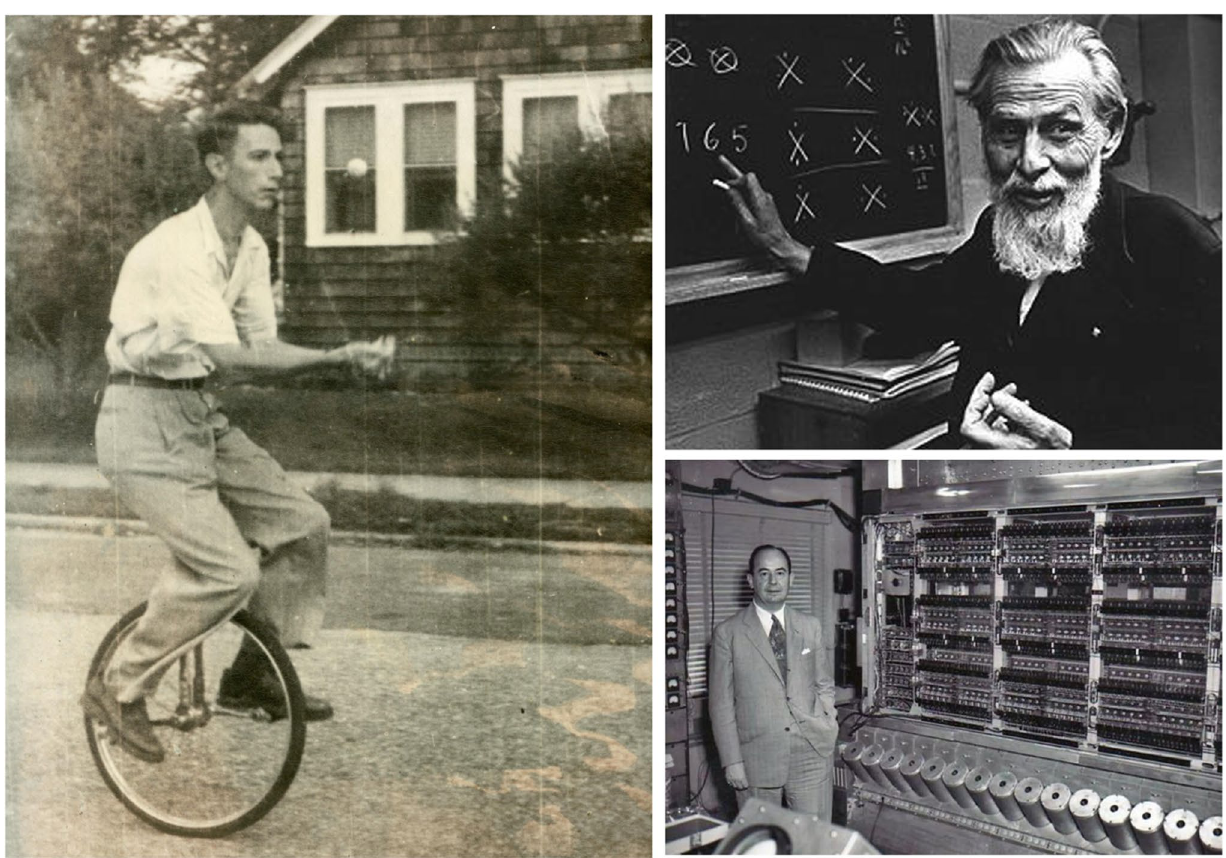
Fig. 3 Claude Shannon and Boolean algebra; Warren McCulloch and electronic analogues of neurons; John von Neumann and binary com-